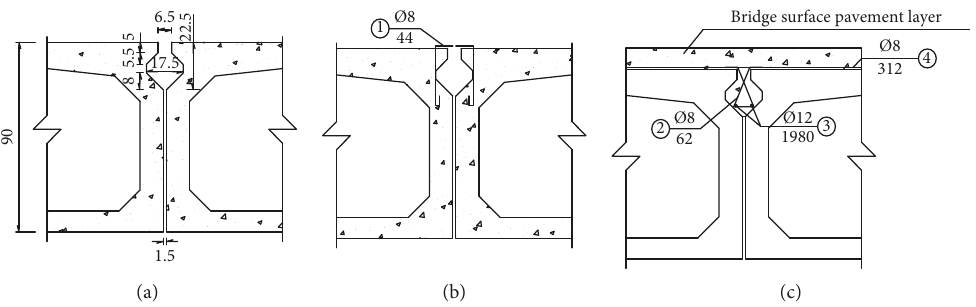
Figure 2: Hinge joint structure and reinforcement (cm): (a) hinge joint detailed drawing, (b) hinge joint connection rebar, and (c) hinge joint rebar.